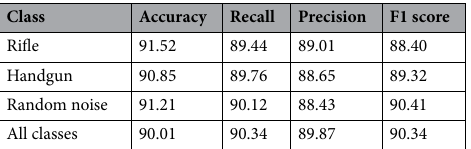
Table 2. 5-Fold cross validation audio classification results in